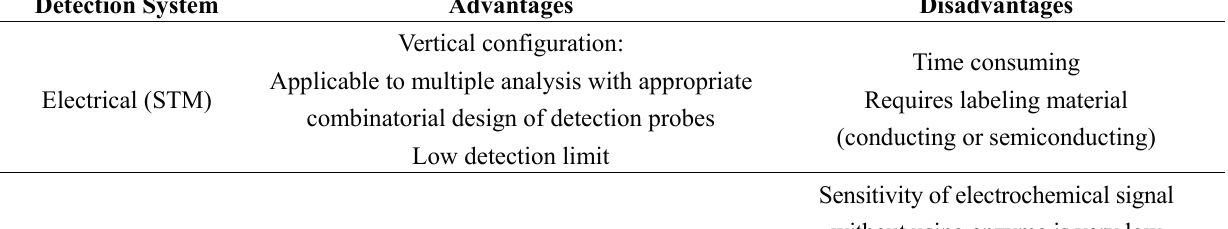
Table 2. Comparison of four technologies based on their advantages and disadvantages. Detection